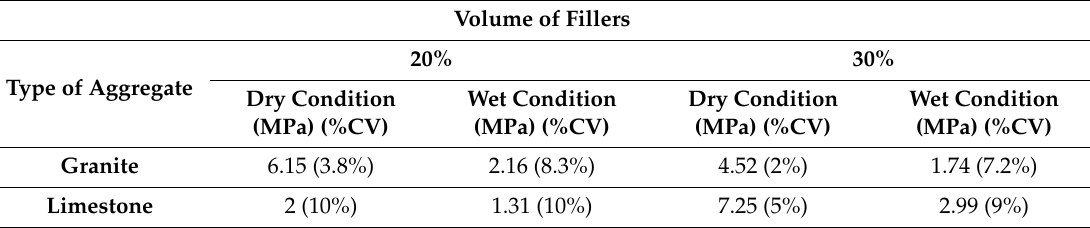
Table 4. Pull-off tensiel strength test (POTS) of dry and wet conditions on asphalt mixtures and different filler contents (i.e., 20% and 30% by volume).